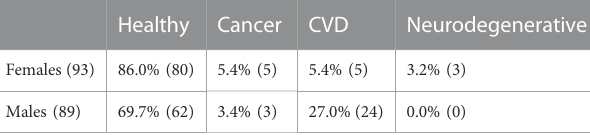
TABLE 1 Repartition of males and females in the medical